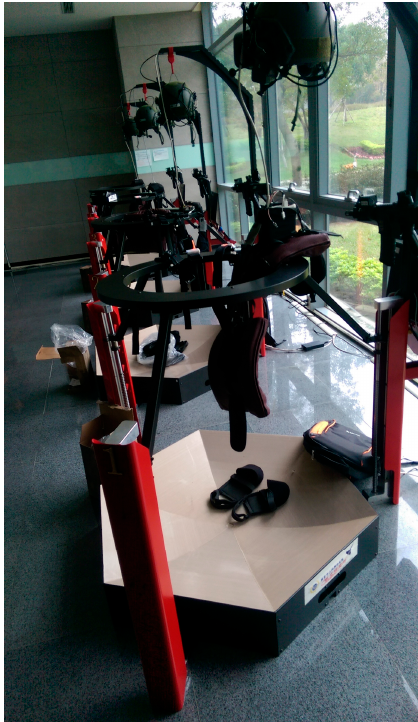
Figure 18. Snapshot of the system.